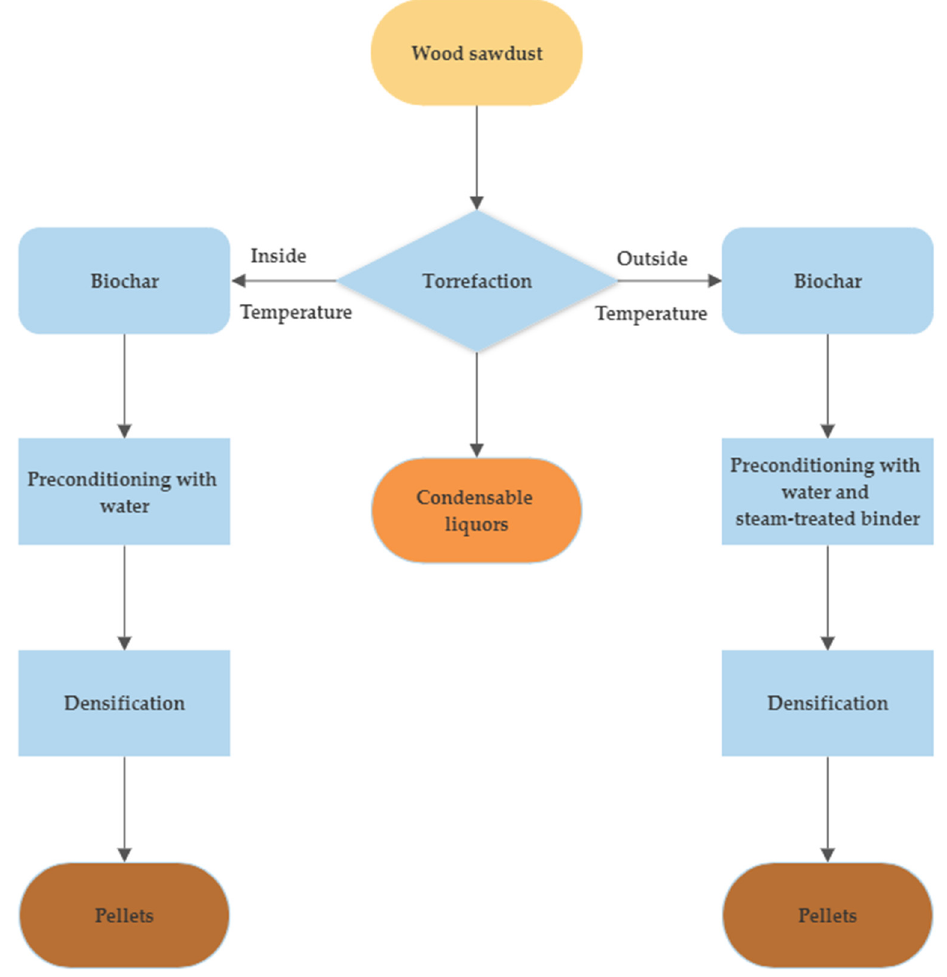
Figure 1. Process flowchart for torrefaction and densification of wood sawdust.